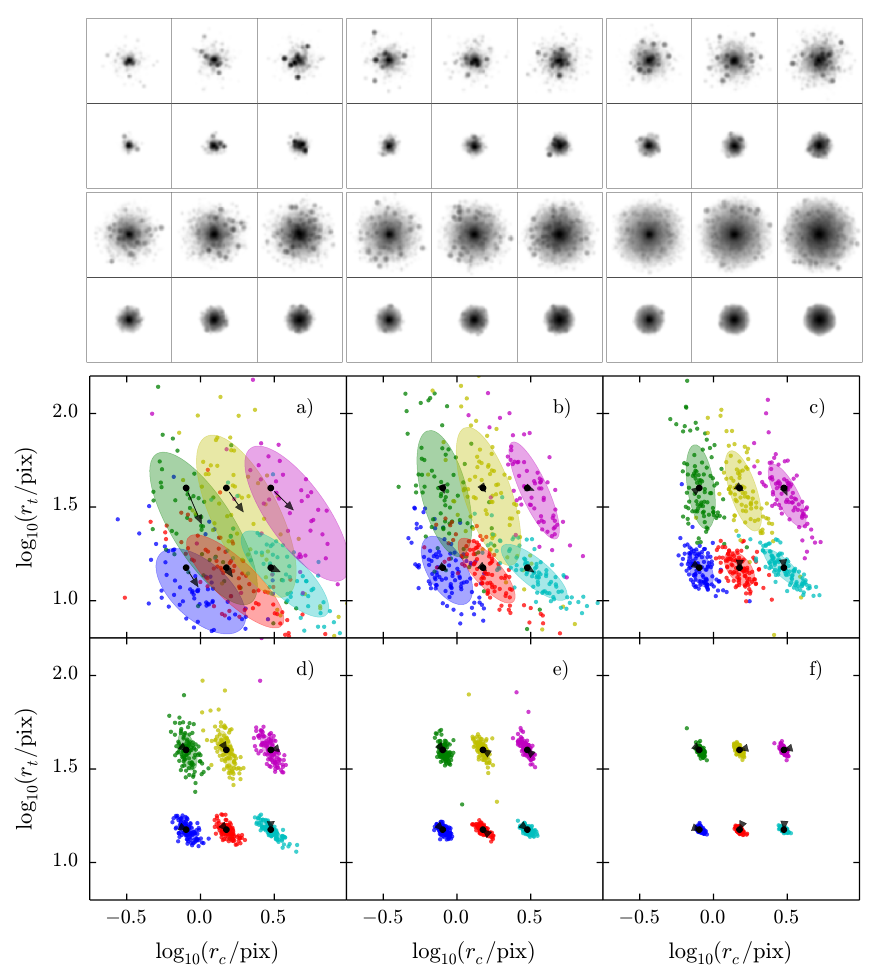
Fig.4. The same as in Fig.1, but for 10 Gyr